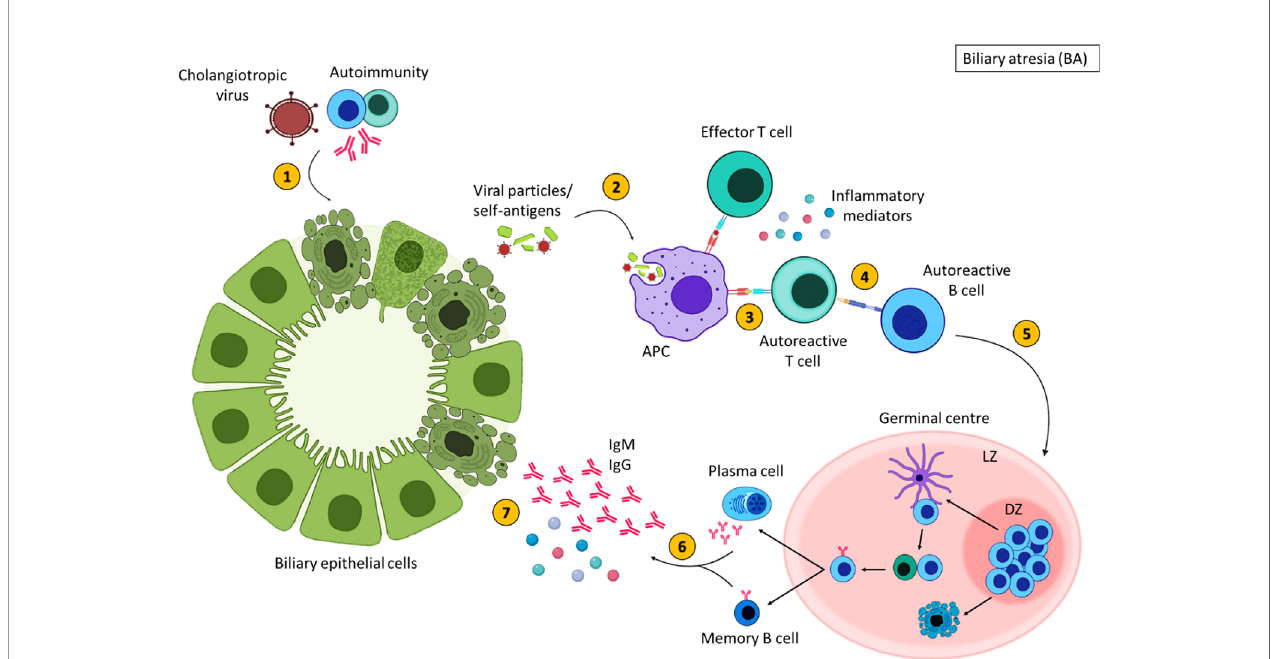
FIGURE 5 | In fl ammatory-mediated damage in biliary atresia. In some children with BA, damage to the extrahepatic bile ducts may occur due to cholangiotropic viruses or autoimmunity (1), resulting in the expulsion of viral or self-antigens. These antigens are engulfed by antigen presenting cells (2) and presented to T cells (3). Autoreactive T cells that recognise self-antigens stimulate autoreactive B cells (4). Activated B cells then migrate to secondary lymphoid tissues and undergo germinal centres reactions (5) where B cells with increased af fi nity receptors differentiate into memory B cells and PCs (6). The secretion of in fl ammatory mediators and autoantibodies from memory B cells and PCs further damage BECs (7). Created with